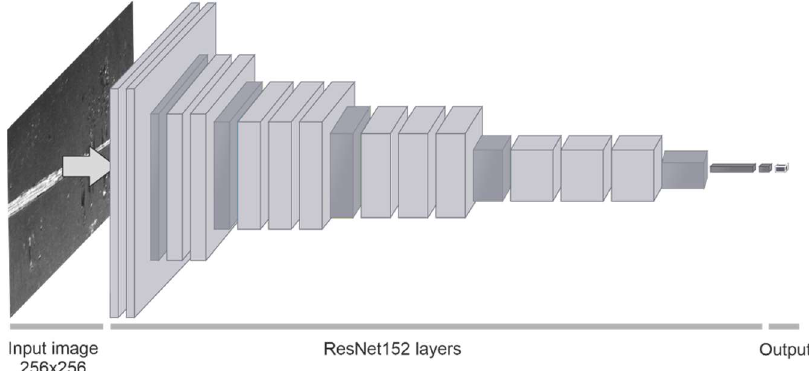
Figure 2. Generalized structure of the defect classifier based on ResNet.